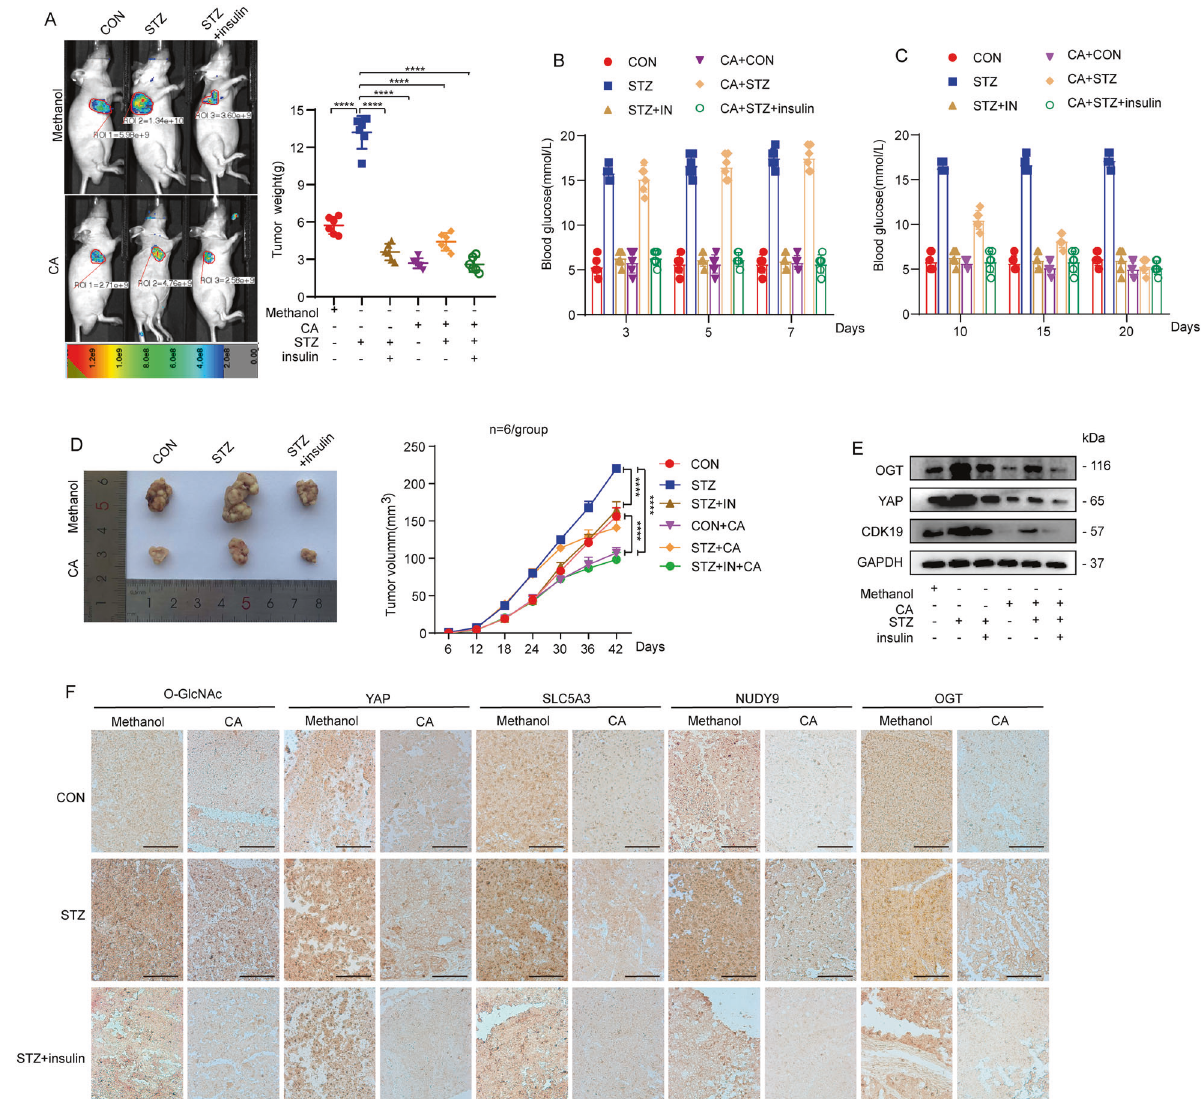
Fig. 3 A Insulin-de fi cient HG and control mouse models were constructed by intraperitoneal injection of STZ and saline, respectively. Bel-7404 cells (5 × 10 6 cells) expressing green fl uorescent protein (GFP) were injected into 8-week-old athymic nude mice with or without STZ treatment and then injected 24 days later with methanol or CA (10 mg/kg/day). B Fasting blood glucose levels of mice were measured on the third, fi fth, and seventh days after STZ injection. C Fasting blood glucose levels of mice were measured on days 10, 15, and 20 after CA injection. D Tumor sizes were monitored in mice for 42 days after subcutaneous injection of Bel-7404 cells. n = 6 per group. E OGT, YAP, and CDK19 were analyzed by WB of xenograft mouse tissues. F Representative IHC images of O -GlcNAc, YAP, SLC5A3, and Nudt9 staining in tissues from methanol- or CA-treated xenograft mice. Scale bars: 200 μ m. Data are shown as mean ± SD. **** P <